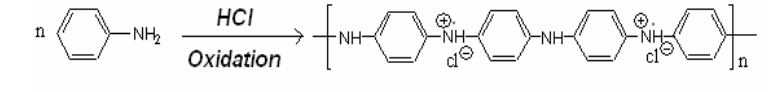
Figure 2. Overall polymerization reaction of